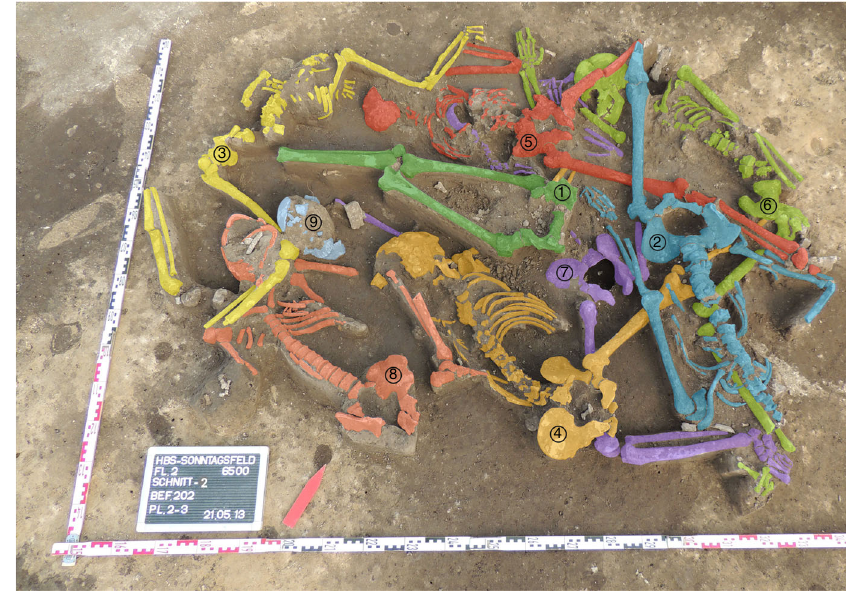
Fig. 1 The mass grave feature in situ. Individual skeletons have been coloured and numbered for better visual differentiation